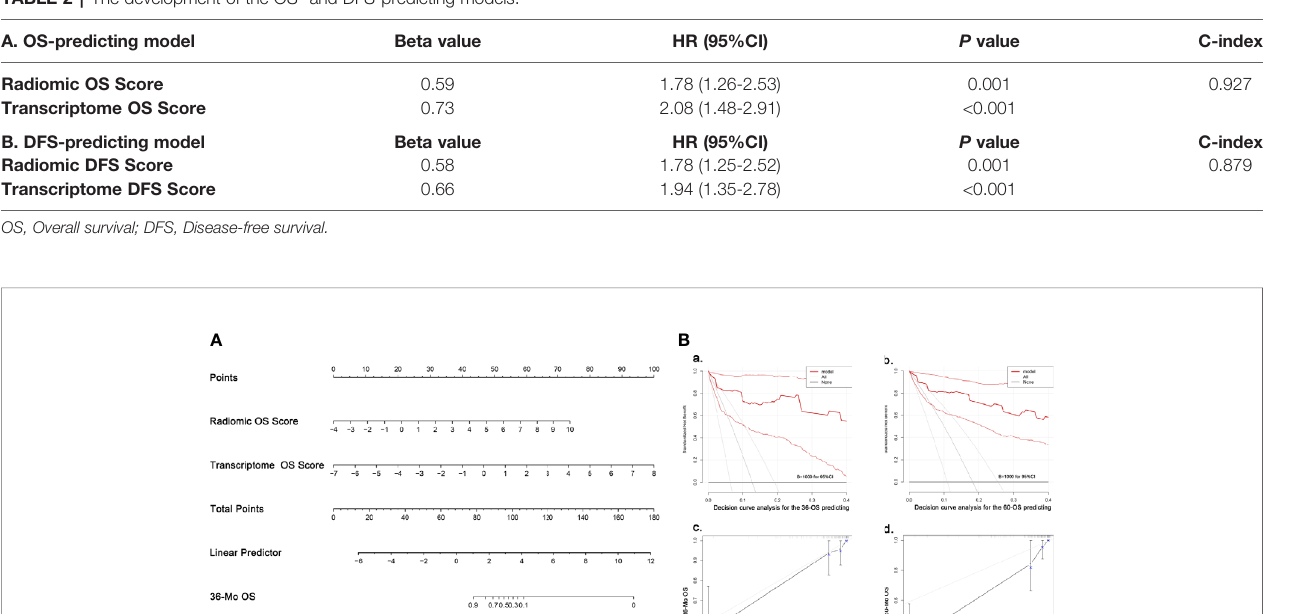
TABLE 2 | The development of the OS- and DFS-predicting models.